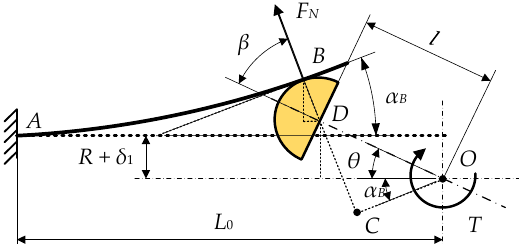
Figure 13. Force diagram of the variable stiffness actuator with clearance (transmission state).